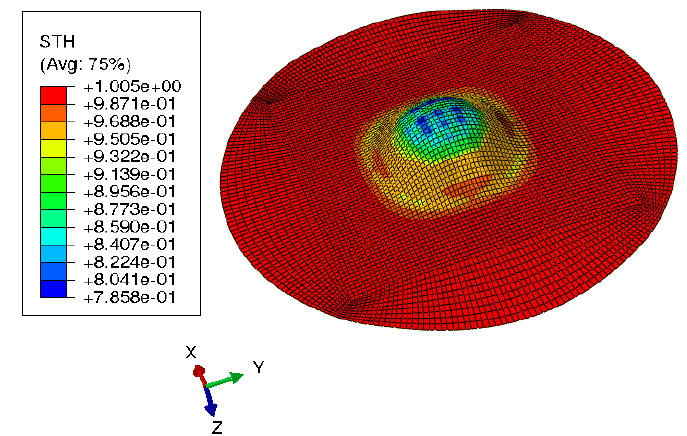
Figure 15. Distribution of shell thickness decreasing at ambient temperature: preforming